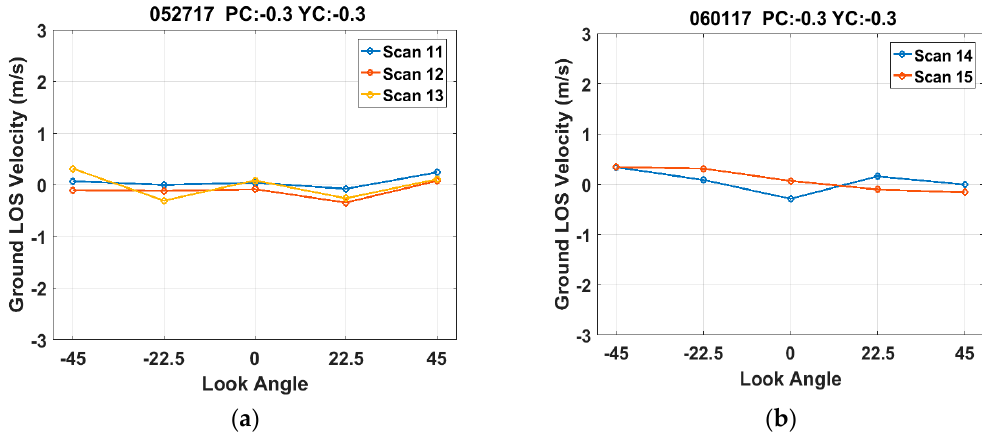
Figure 6. LOS velocities at the ground for each look of 5-look scans during cloud free constant altitude flight segments over uniform terrain of the Florida peninsula on 27 May 2017 ( a ) and 1 June 2017 ( b ).